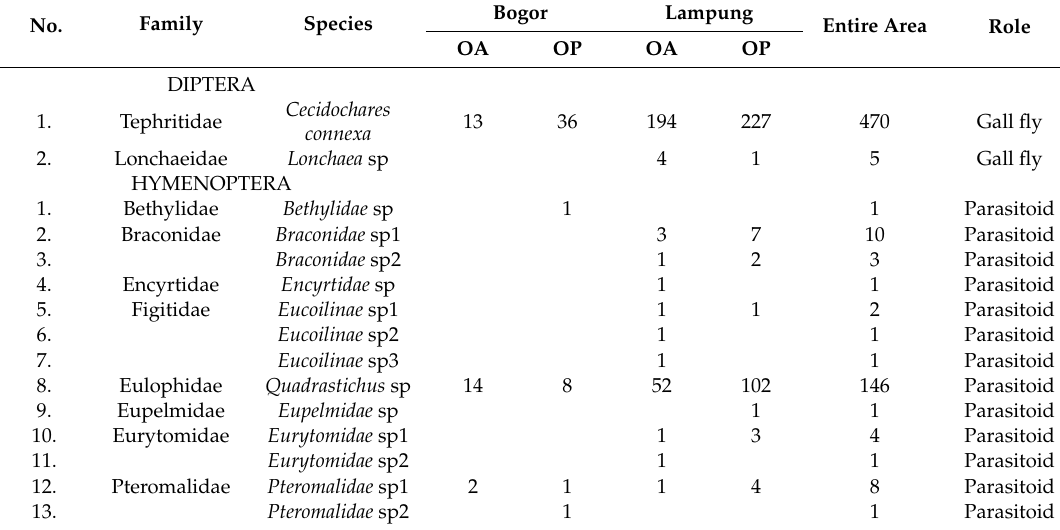
Table 2. Species richness and abundance of gall flies and associated parasitoid wasps that emerged from gall samples. OA = open area, OP = oil palm